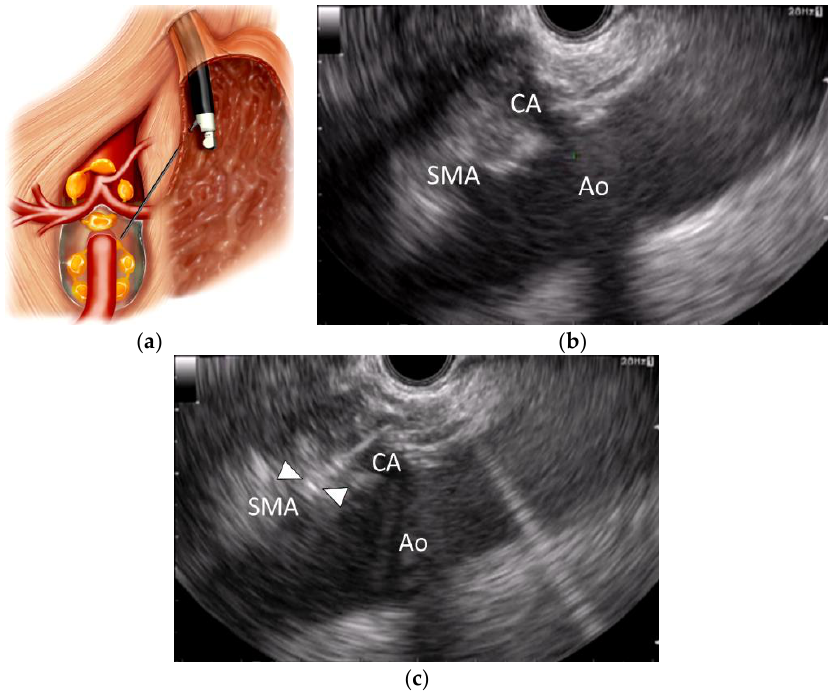
Figure 3. Endoscopic ultrasound-guided broad plexus neurolysis (EUS-BPN). ( a ) Schematic of EUS-BPN; ( b ) EUS image from the lesser curvature of the stomach showing a longitudinal view of the aorta (Ao), celiac artery (CA) and superior mesenteric artery (SMA); ( c ) EUS image of EUS-BPN during needle puncture. A 25-gauge needle was advanced adjacent to the SMA. Arrowheads indicate the needle tip.